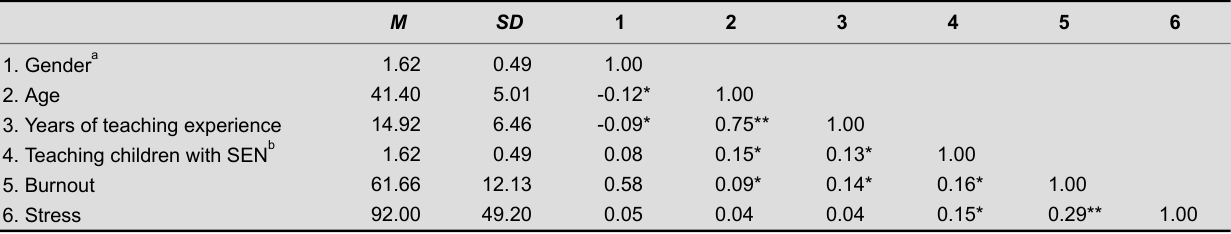
Means, Standard Deviations and Intercorrelations Among the Variables